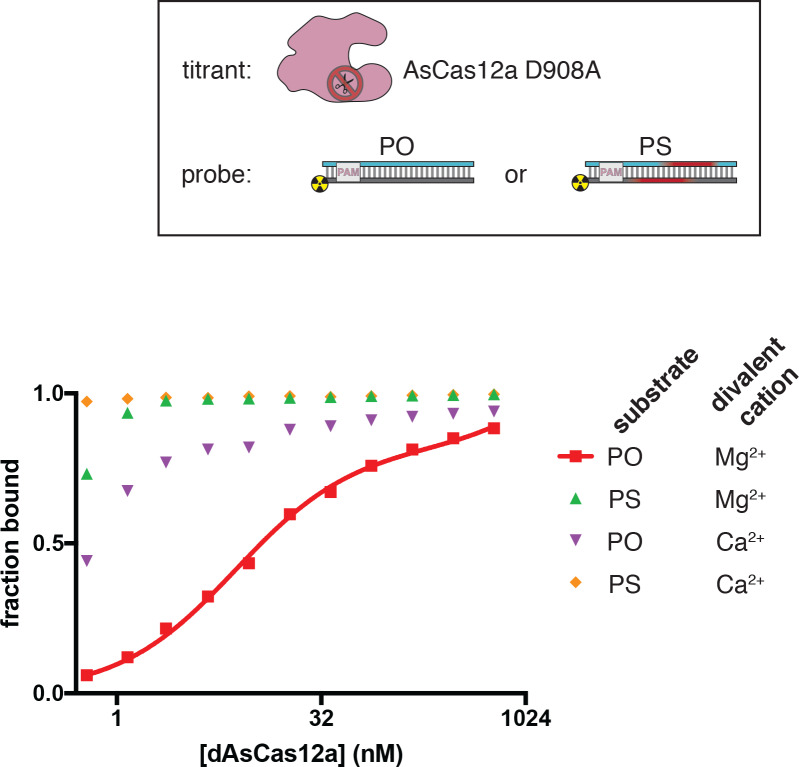
Interference complexes are stable in the presence of CaCl2 and with a phosphorothioated DNA target.Using a filter-binding assay, we assessed the affinity of dAsCas12a/crRNA for cognate DNA targets, either fully phosphodiester (PO) or containing phosphorothioate (PS) linkages across the NTS and TS cleavage sites, in the presence of either 5 mM MgCl2 or 5 mM CaCl2. Substrate diagrams are colored as in Appendix 2—figure 2—figure supplement 1. ‘Fraction bound’ is defined as (background-subtracted volume of Protran spot)/(total background-subtracted volume of Protran spot + Hybond N+ spot). The value of ‘fraction bound’ was 0 at [dAsCas12a]=0 for both substrates and both assays (not shown due to the logarithmic x-axis). All data shown are from a representative replicate (n = 3). When appropriate, data were fit to the sum of a hyperbola and a line (y = Bmax*x/(KD+x)+NS*x), where NS describes a non-specific binding mode. It is common to see Bmax values below 1 in filter binding assays, in which the process of physical separation can disrupt bound species. KD for the PO substrate in MgCl2 was 8.1 nM ±0.8 (SD) (n = 3). Data from the other binding conditions indicated that the KD was near or below [DNA probe], preventing accurate KD determination by hyperbolic fitting. For unknown reasons, the Mg2+→Ca2+ and the PO→PS substitutions stabilized the ribonucleoprotein:DNA interaction both separately and together.